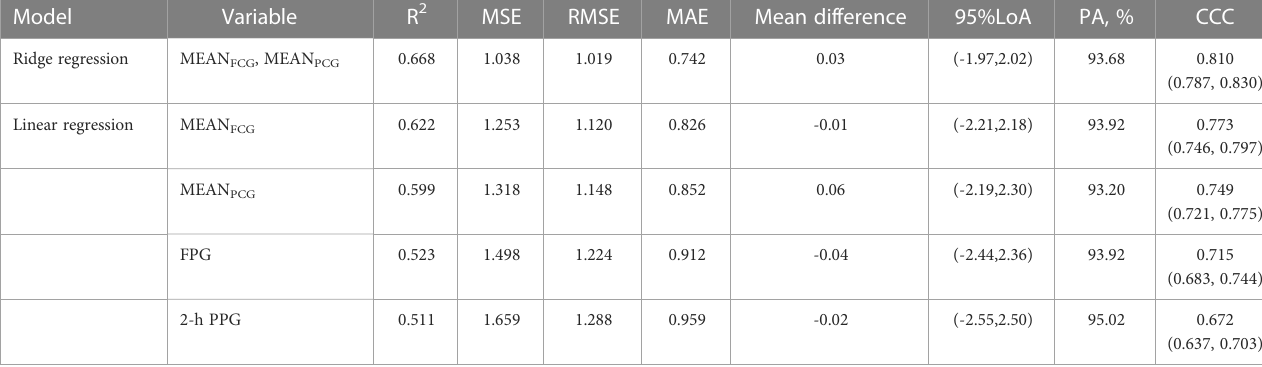
TABLE 2 The comparison of ridge regression model and simple linear regression model for HbA1c. Model